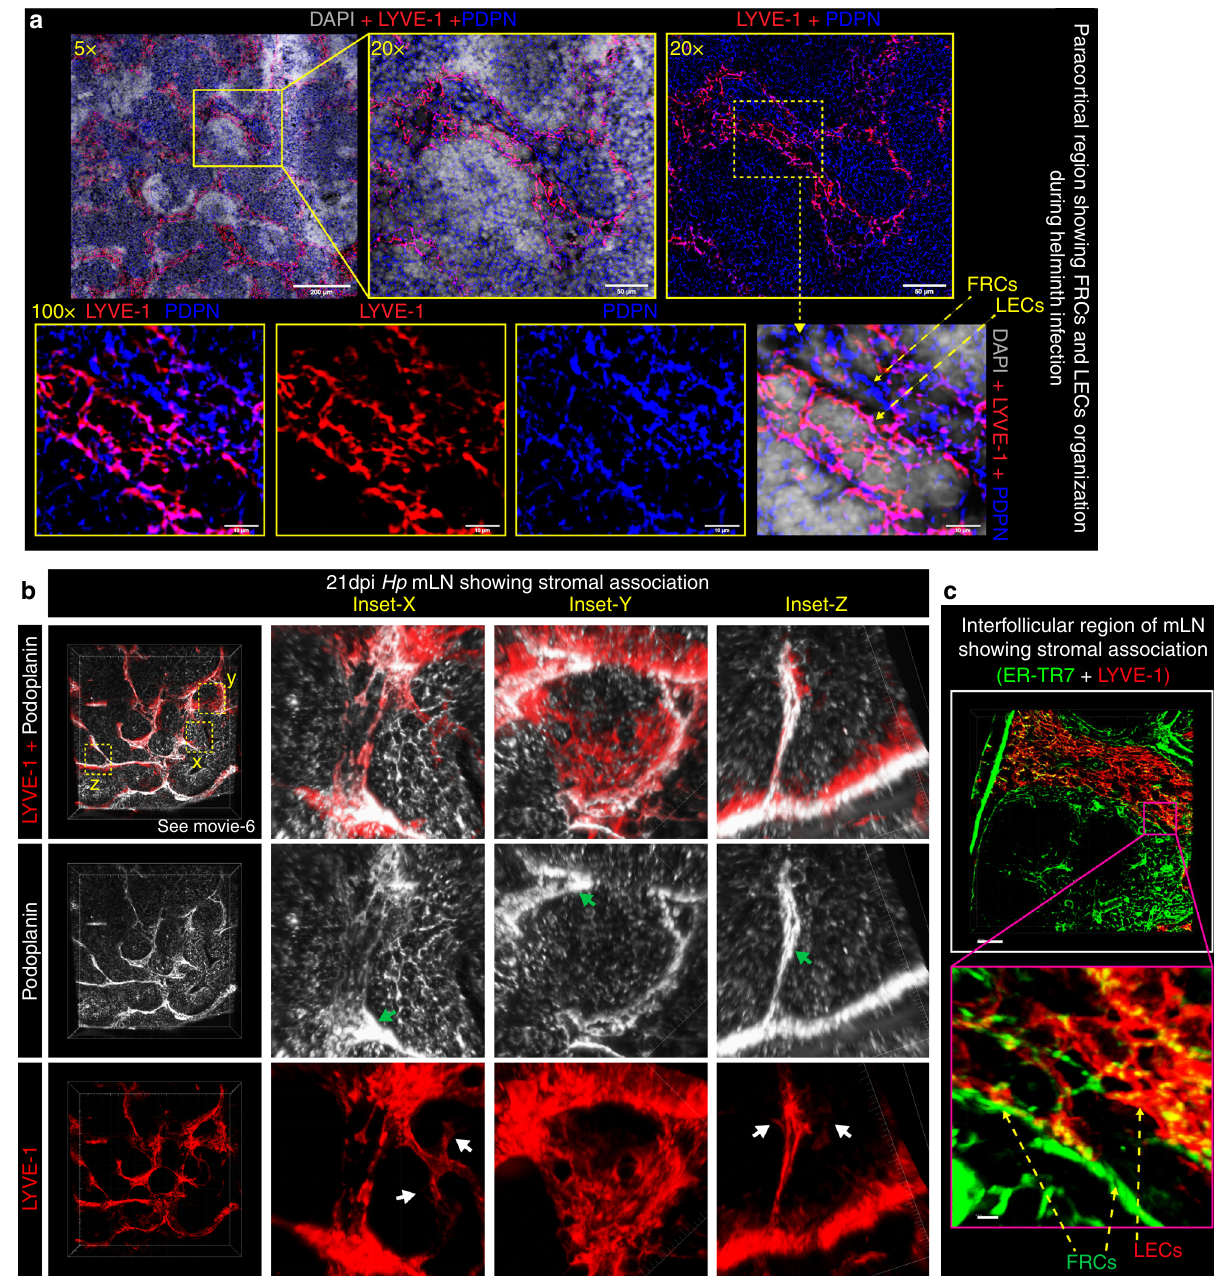
Fig. 2 LECs and FRCs form intimate contacts in the area surrounding B-cell follicles. C57BL/6 J wild-type mice were infected with Hp and the entire chain of the mLN collected at 21 dpi. a 8 μ m thick mLN cryosections showing combined immuno fl uorescence staining for FRCs (PDPN + ; blue ) and LECs (LYVE-1 + ; red ) of Hp -infected mice are shown at various magni fi cations. Scale bar 50 μ m. b Vibratome sections of ≥ 100 μ m thick mLN showing 2D and 3D views of paracortical LECs ( red ; PDPN + LYVE-1 + ) and FRCs ( gray ; PDPN + LYVE-1 − ) lying in close vicinity of one another and surrounding a centrally located B-cell follicle. Insets ( x , y , z ) show higher magni fi cation of FRCs and LECs. Green and white arrows highlight quiescent and sprouting lymphatic vessels respectively. c Vibratome sections of thick mLN section showing the mLN interfollicular region and highlighting associations between FRCs and LECs. All images are taken from a single mouse and are representative of two or more independent experiments, each including n ≥ 2 mice/group/time-point. See also Supplementary movie